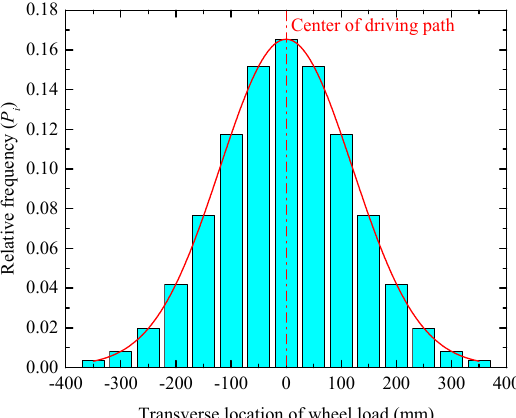
Figure 17. Transverse distribution of the wheel load.